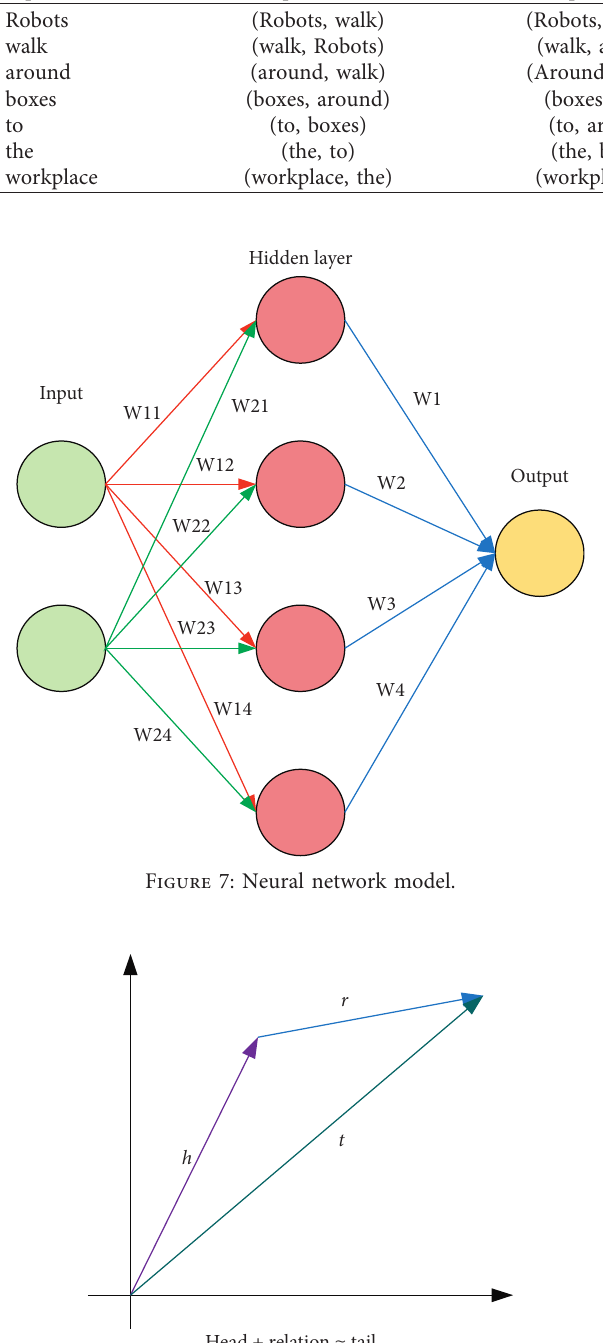
Figure 8: Schematic diagram of TransE